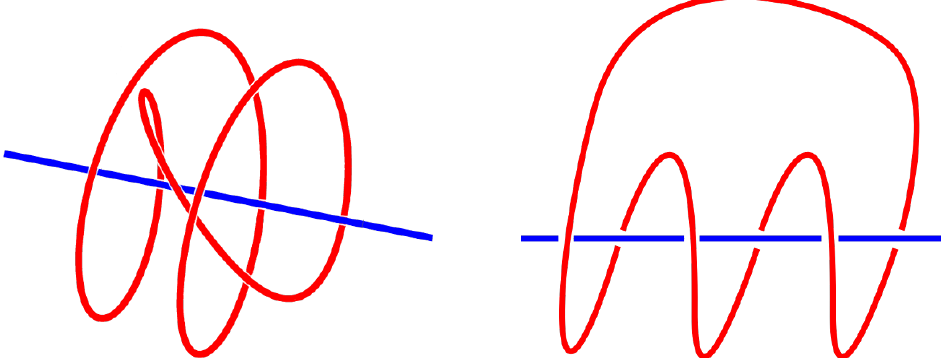
Figure 2 . The left image shows a plot of the link that is formed by (cid:1) 1 = 0 (red) and z 3 = 0 (blue) inside a small 3-sphere around the point z 1 = 1 ; z 3 = 0 in the complex structure moduli space of the mirror of X 18 . We use stereographic coordinates on the 3-sphere and the blue line closes at in(cid:12)nity. The right image shows an equivalent